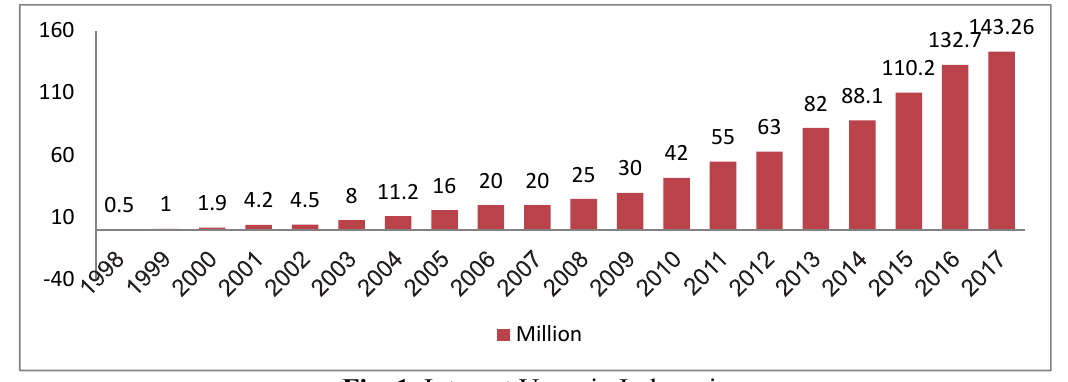
Fig. 1. Internet Users in Indonesia (www.apjii.or.id, 2017)